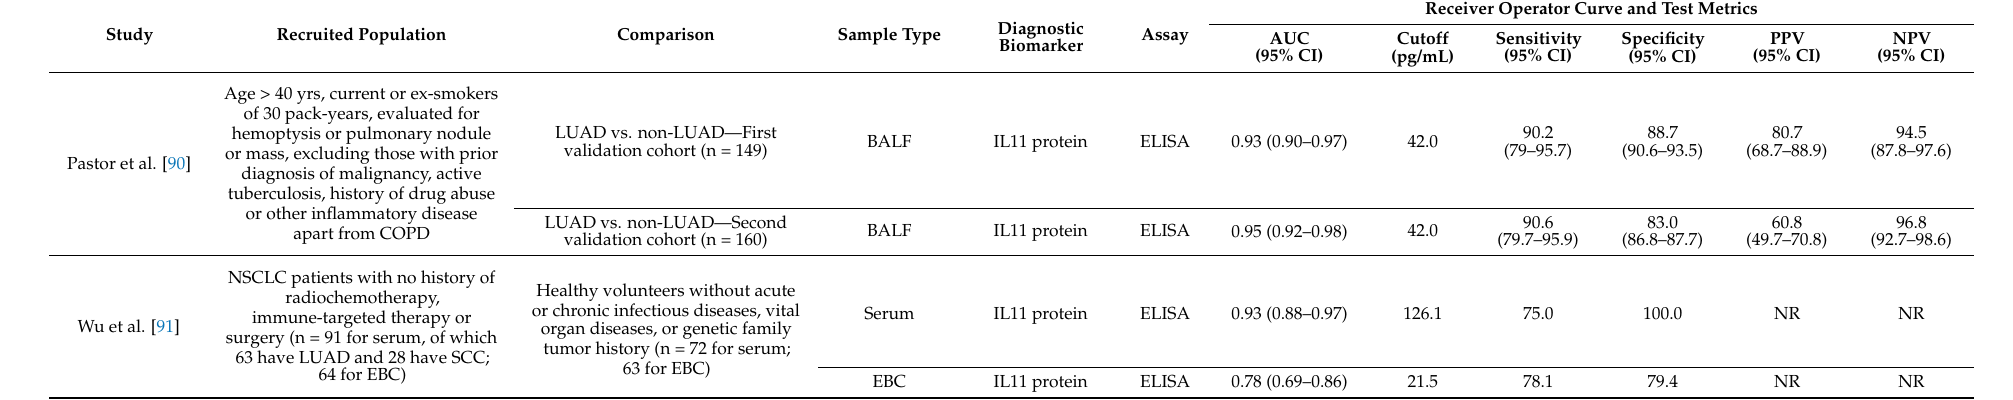
Table 2. Studies identifying IL11 as a diagnostic